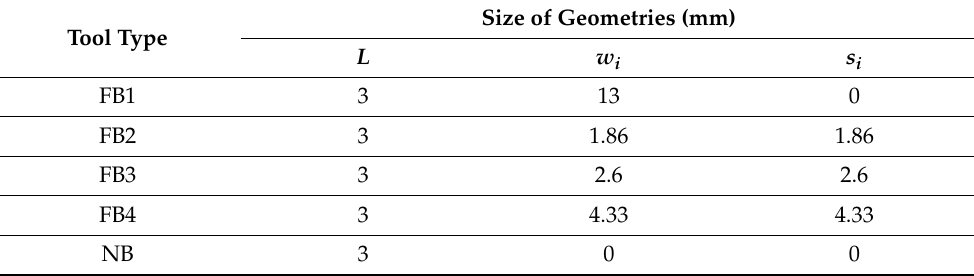
Table 5. Types and geometric parameters of broach flocking.